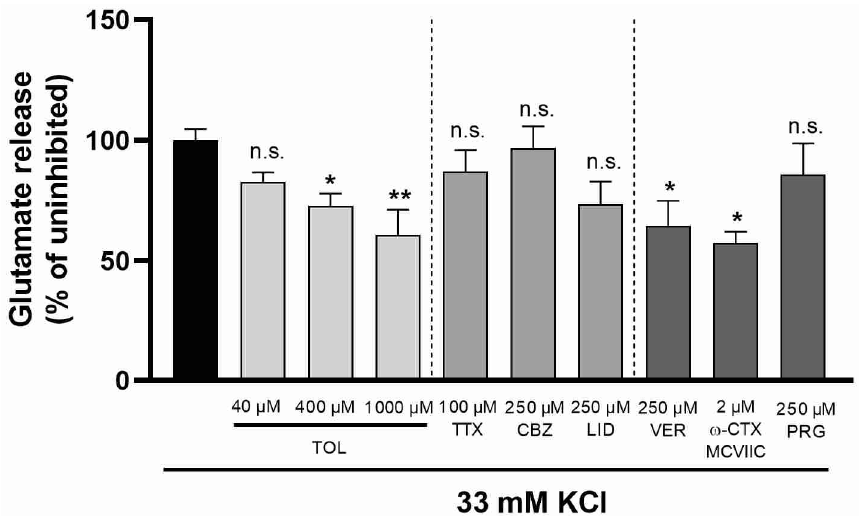
Figure 5. Effect of tolperisone, sodium channel blockers (TTX—tetrodotoxin; CBZ—carbamazepine; LID—lidocaine), and calcium channel blockers (VER—verapamil; ω -CTX— ω -conotoxin; PRG—